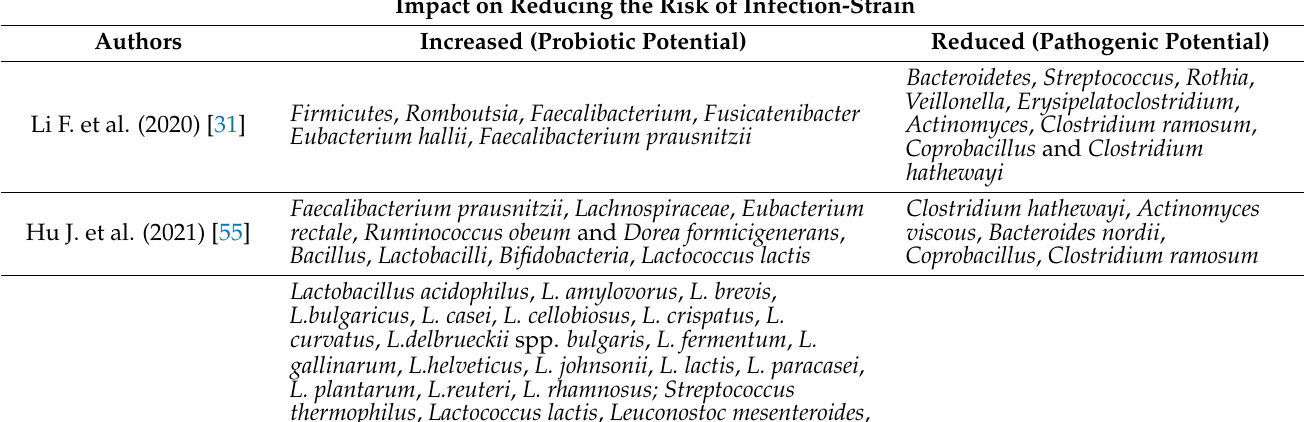
Table 1. Impact of probiotic strains on reducing the risk of SARS-CoV-2 virus